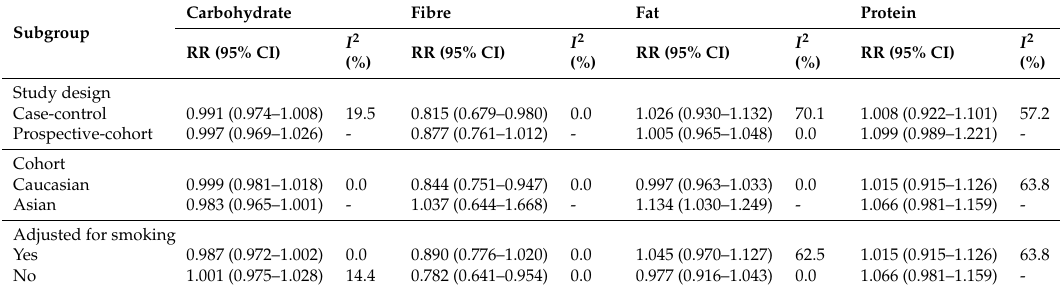
Table 3. Subgroup analyses (random effect model) of carbohydrate, fiber, fat and protein intake (per 10 g increment/day) with the risk of Crohn’s